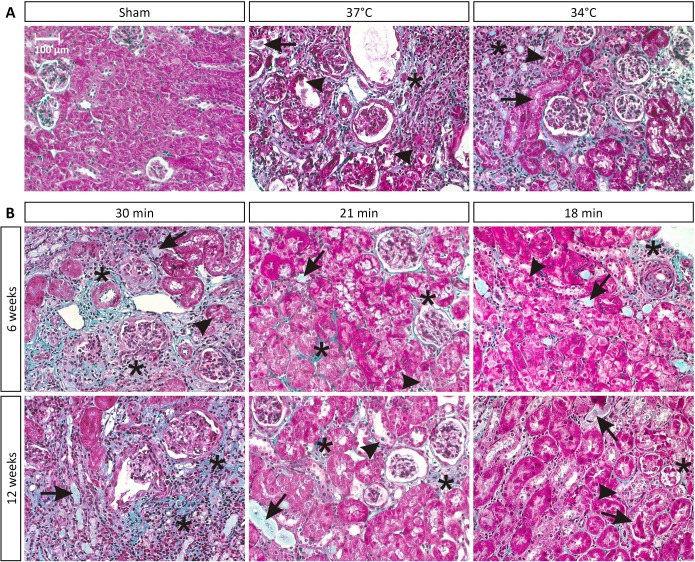
Photos of Masson’s stained slides of ischemic kidney tissue.The images shown are representative of the group. Masson’s stain showed prominent renal damage and severe loss of structure, with necrotic cells (arrowhead), casts or intraluminal debris (arrow), inflammatory infiltration and fibrosis (*). Blue stain represents extracellular matrix deposition (i.e. fibrosis). Magnification: 200x. A: Effect of body temperature on long-term fibrotic outcome 12 weeks after UIRI. B: Effect of ischemia time on long-term fibrotic outcome 6 and 12 weeks after UIRI.